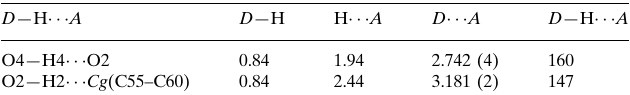
Hydrogen-bond geometry (A˚ , (cid:2)